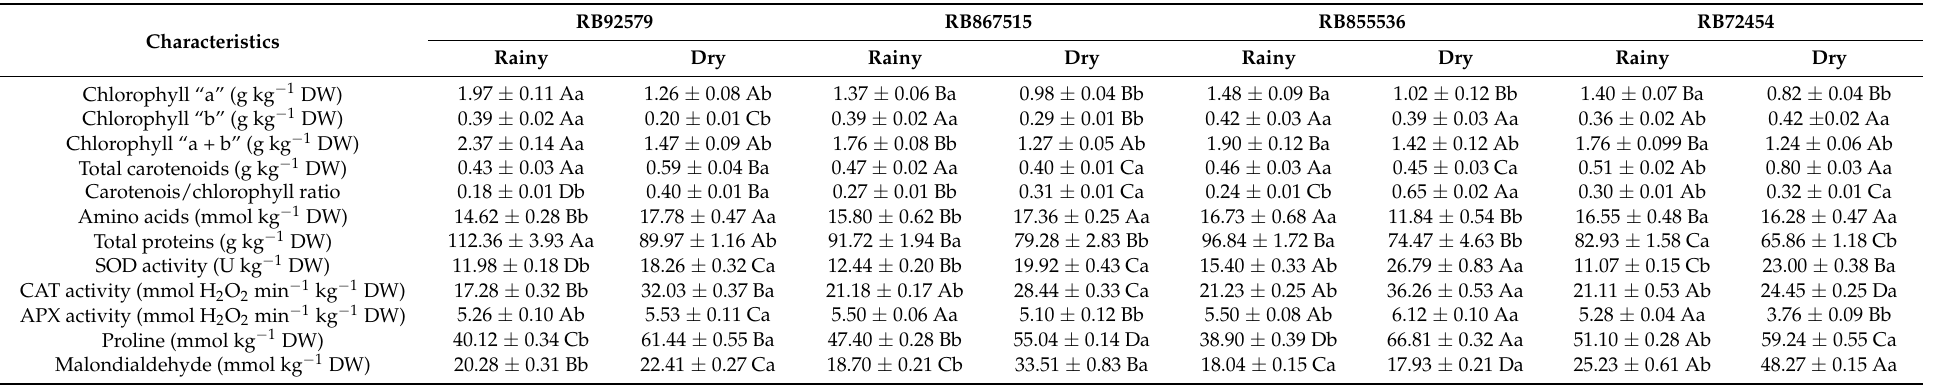
Table 2. Biochemical and antioxidative features measured of four varieties (RB92579, RB86751, RB855536, and RB72454) of sugarcane. The evaluations were made in rainy season (2020, July) and dry season (2020, December) at 8:00 to 10:00 h. Different lowercase letters denote significance within season for each variety, and different capital letters denote significance within varieties for the same season. All value denotes median ± SE (n =